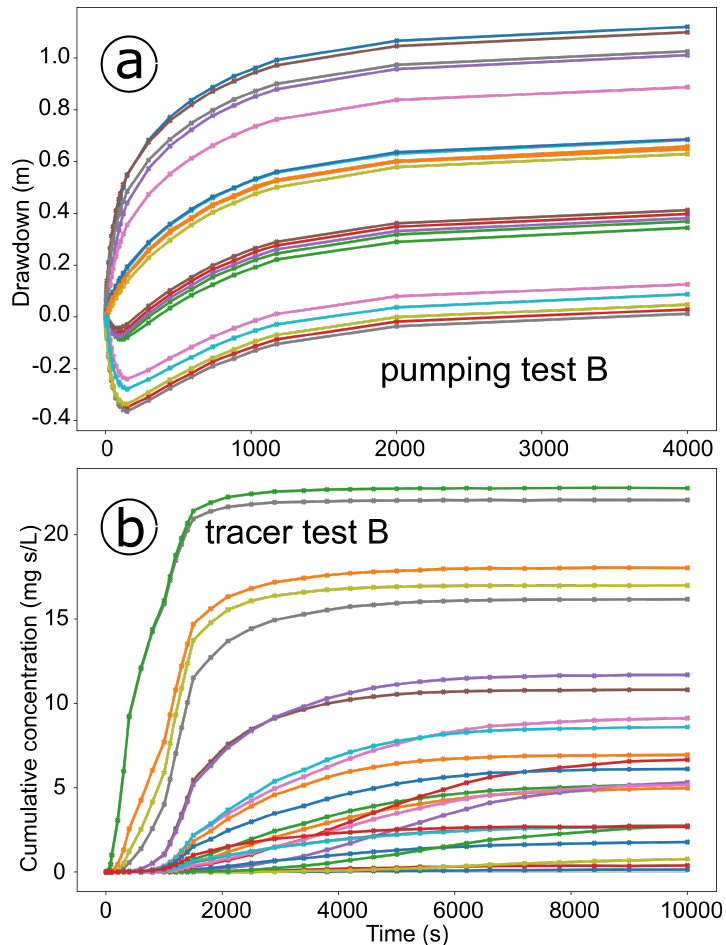
Figure 3. Synthetic drawdown ( a ) and cumulative breakthrough curves ( b ) for pumping and tracer test B,